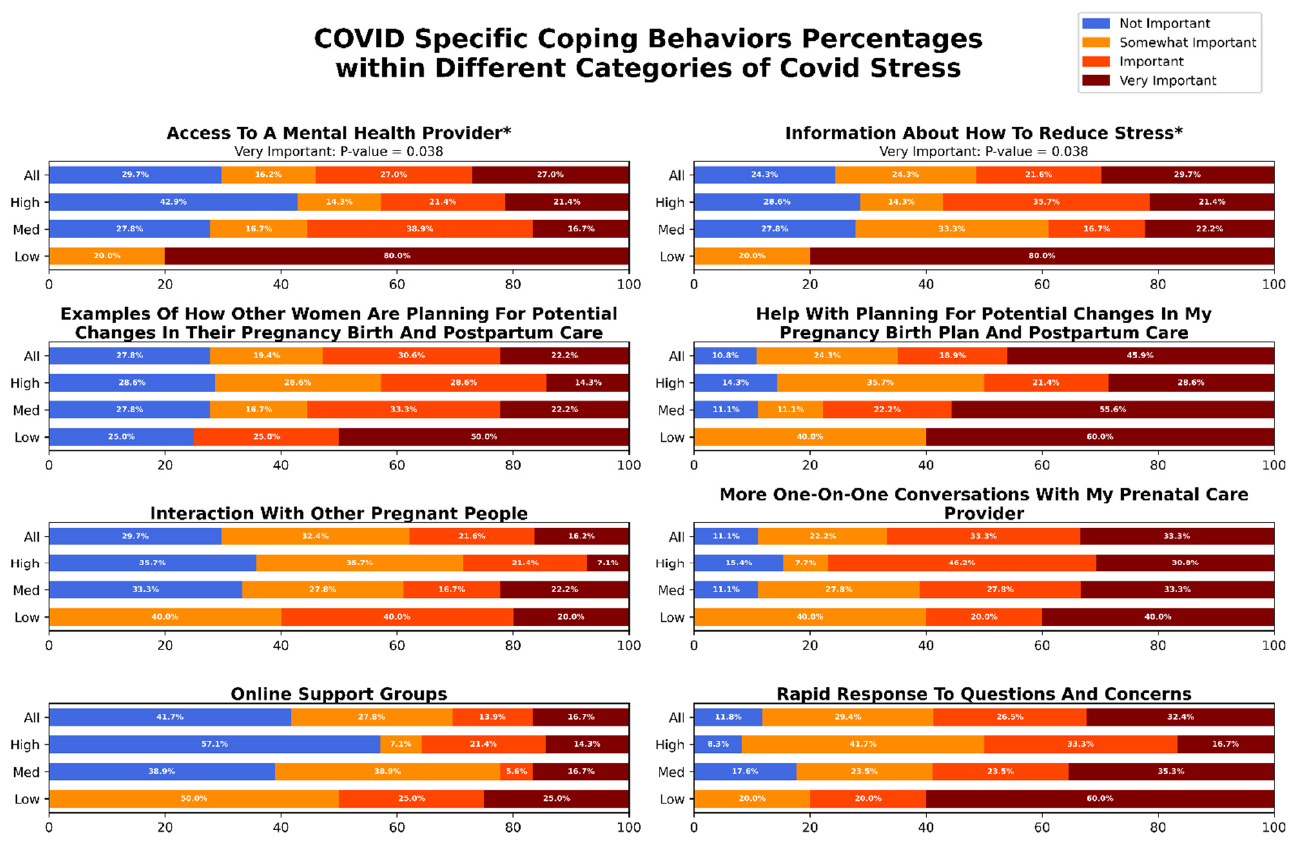
Figure 2. Self-reported importance of potential resources for management of stress associated with COVID-19 related disruptions among pregnant women in the study. The first row for each subscale represents the entire cohort. The second, third, and fourth rows correspond to prevalence of coping behaviors in participants reporting high, medium, and low COVID-19 related stress. * Denotes subscales with significantly different prevalence of use between mothers reporting high and low stress levels.